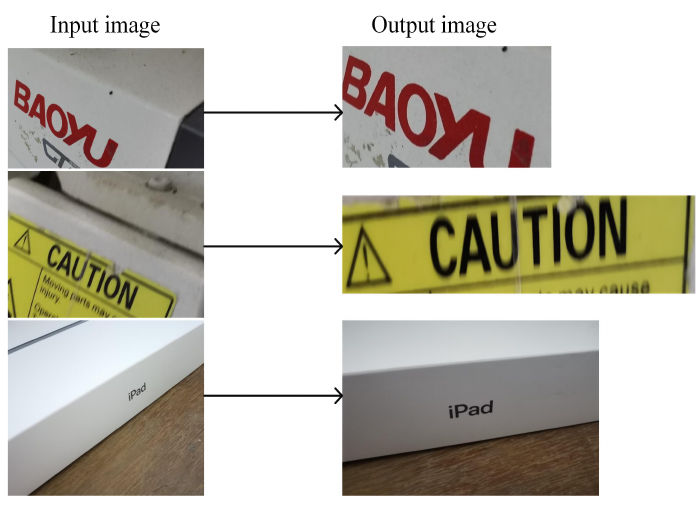
Figure 9. Corrected